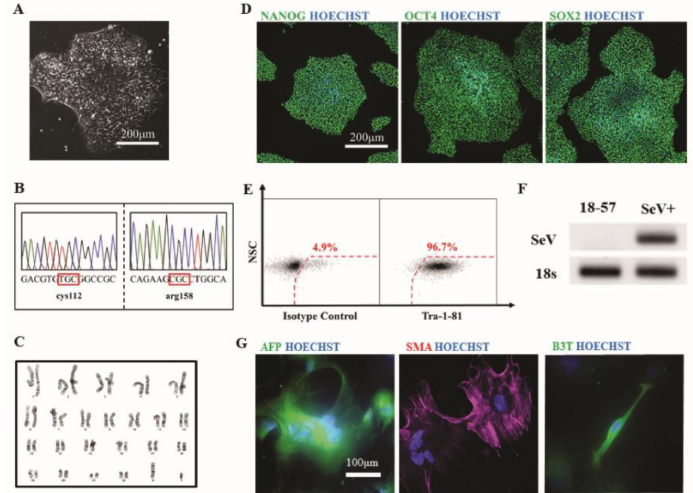
Figure 6. Characterization of human induced pluripotent stem cells (hiPSCs) derived from scalp fibroblast cultures. ( A ). Phase contrast image of a representative clone. ( B ). Sanger sequencing analysis of exon 4 of the APOE gene confirms homozygosity for the e3 allele. ( C ). Karyotype analysis of a representative clone reveals a normal male euploid karyotype. ( D ). Immunofluorescence staining for pluripotency markers NANOG, OCT4, and SOX2. ( E ). Flow cytometry analysis of pluripotency-related marker TRA-1-81. ( F ). RT-PCR analysis demonstrates absence of SeV transgenes in expanded hiPSCs. Sendai virus infected fibroblasts were used as a positive control. ( G ). Immunofluorescence staining of embryoid bodies for markers associated with endoderm (AFP), mesoderm (SMA), and ectoderm (B3T). Nuclei were counterstained in blue